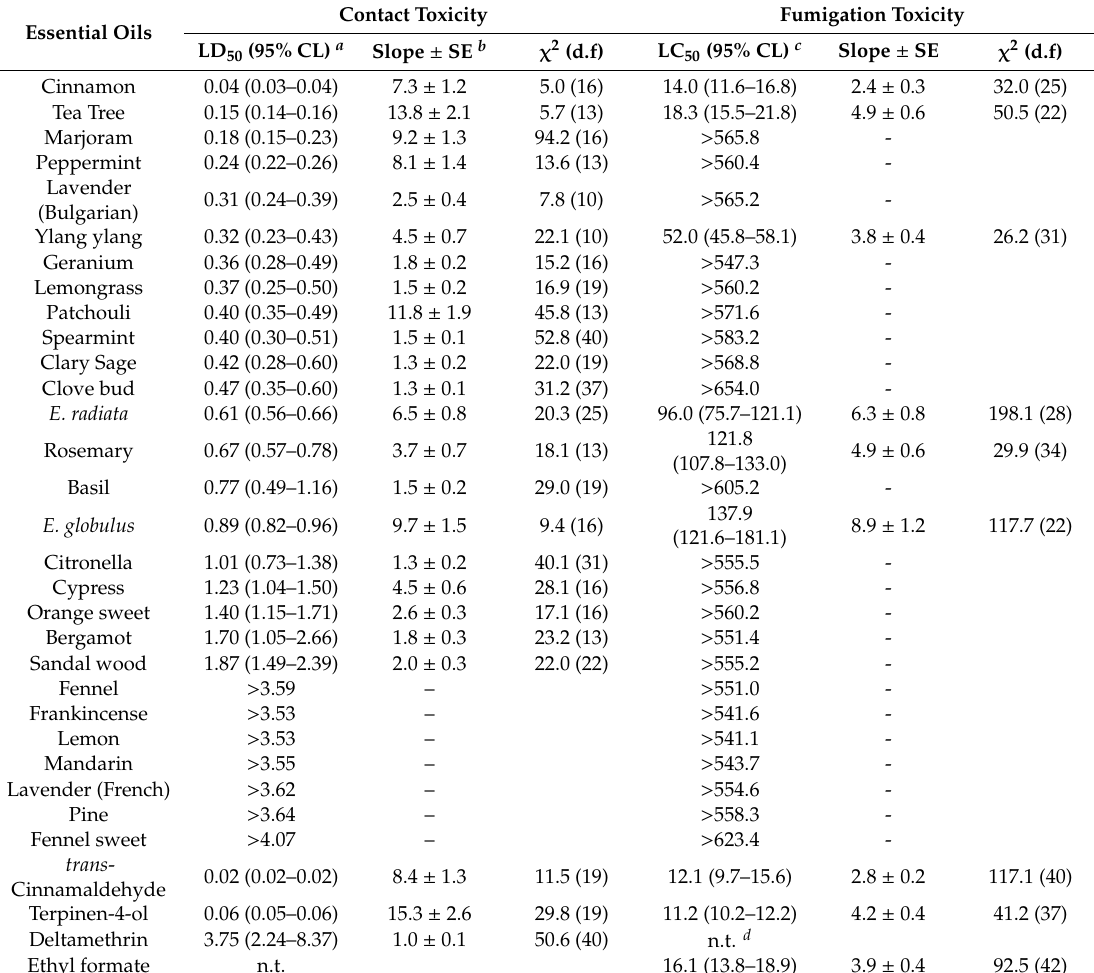
Table 2. Insecticidal activity of 28 essential oils against Sitophilus zeamais